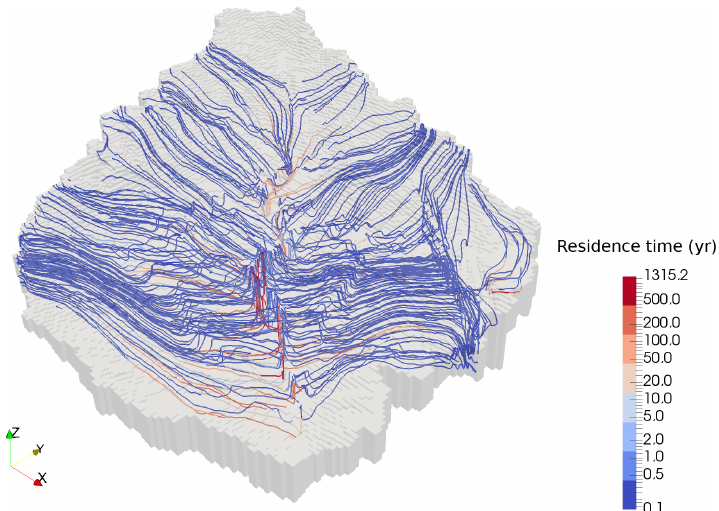
Figure 6. 3-D view of flow pathlines of some particles in realization R5K1. Note that only a limited number of particle pathlines are displayed